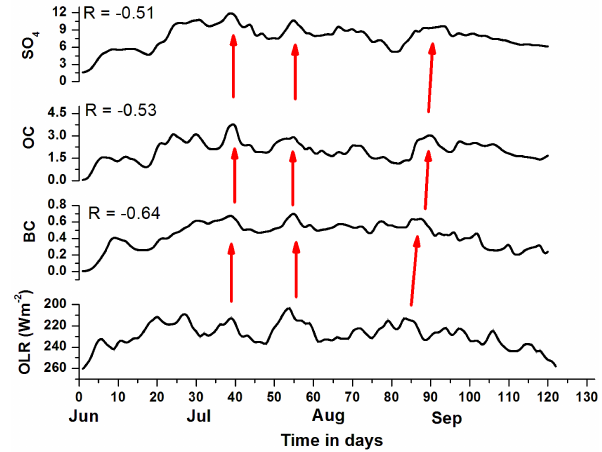
Fig. 7. Time series of outgoing long-wave radiation (OLR) (Wm − 2 ) averaged over 15–30 ◦ N, 60–120 ◦ E and ECHAM5- HAMMOZ-simulated concentrations (ngm − 3 ) of BC, OC, SO 2 − averaged over 20–30 ◦ N and 60–120 ◦ E. Note that the scale for OLR is inverted. The anti-correlation coefficient of BC, OC, and SO 2 − with OLR is indicated at the top of the each